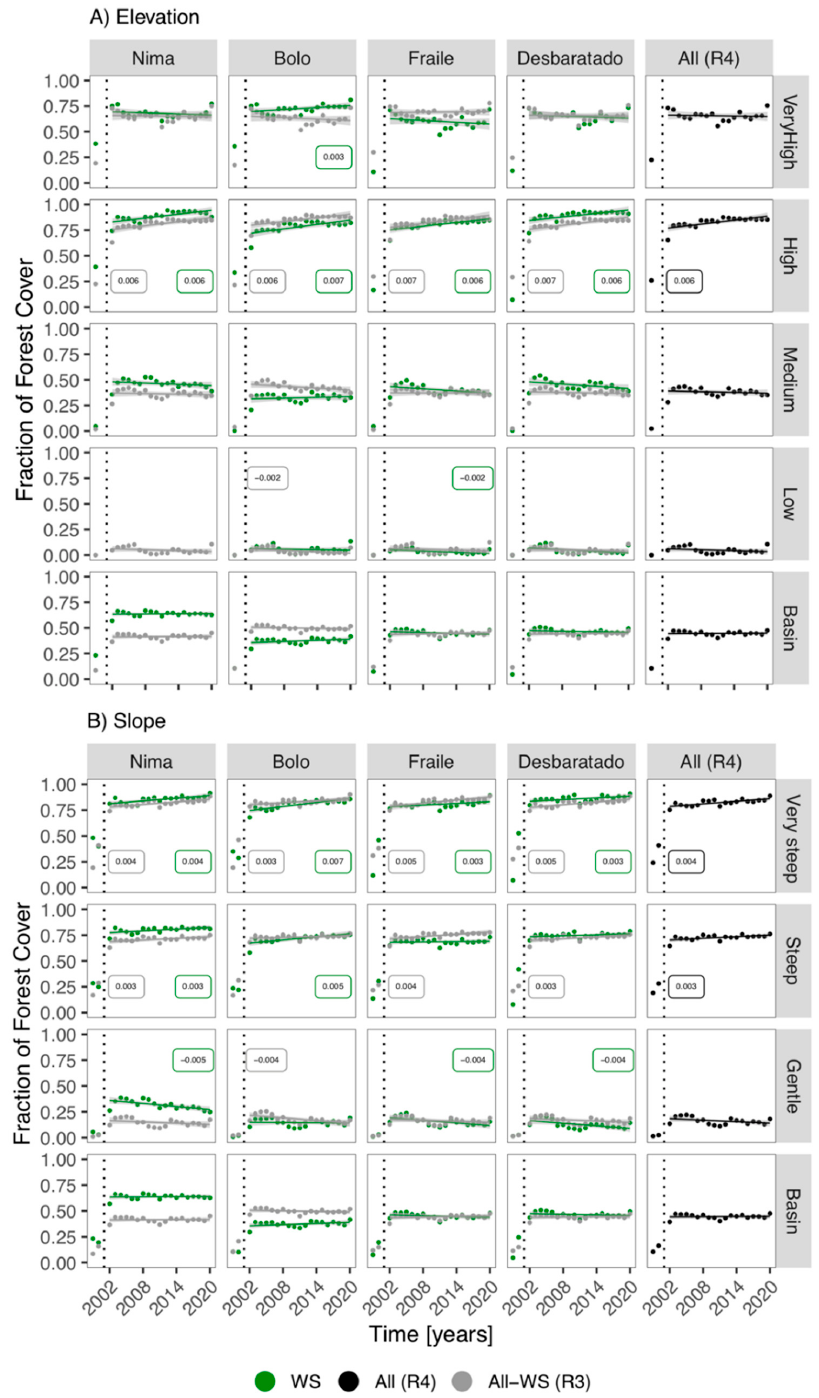
Figure 4. Temporal variation of fractional forest cover ( p i ) as a function of ( A ) elevation and ( B ) slope at regional (black; R4), watershed (green; WS i ), and sub-regional (grey: R3) scales. The vertical dotted line separates the historic and current datasets. Numbers within rectangles represent significant slopes in linear models.